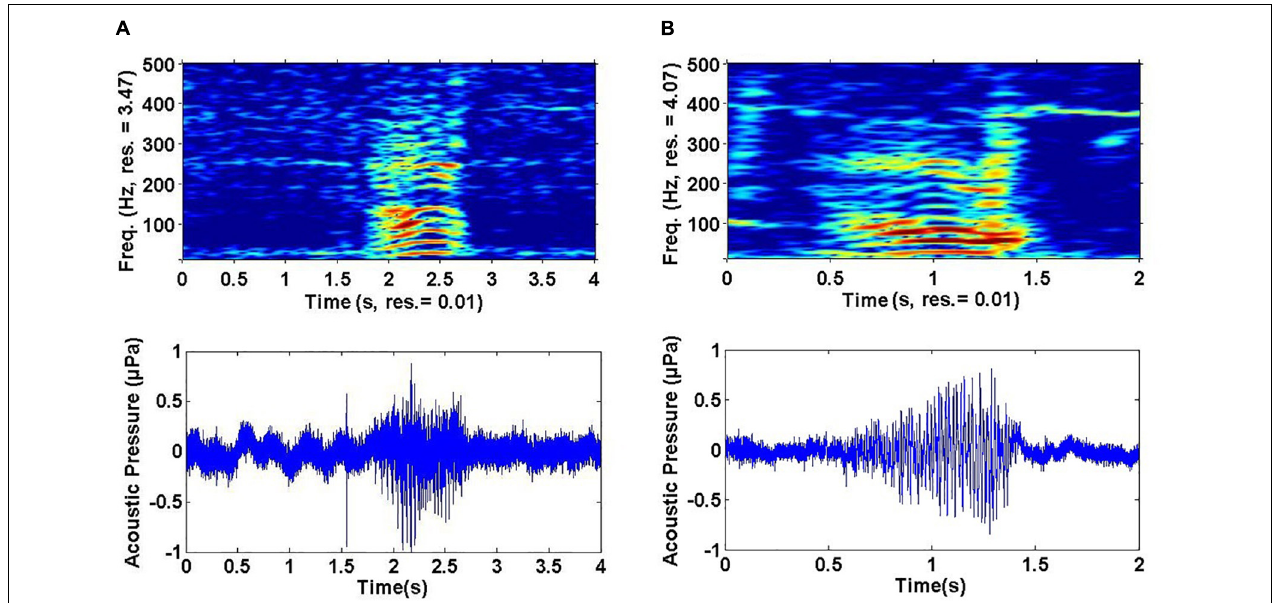
FIGURE 3 | Example of spectrograms showing variability for non-song sounds: (A) HW-02 and (B) HW-05.